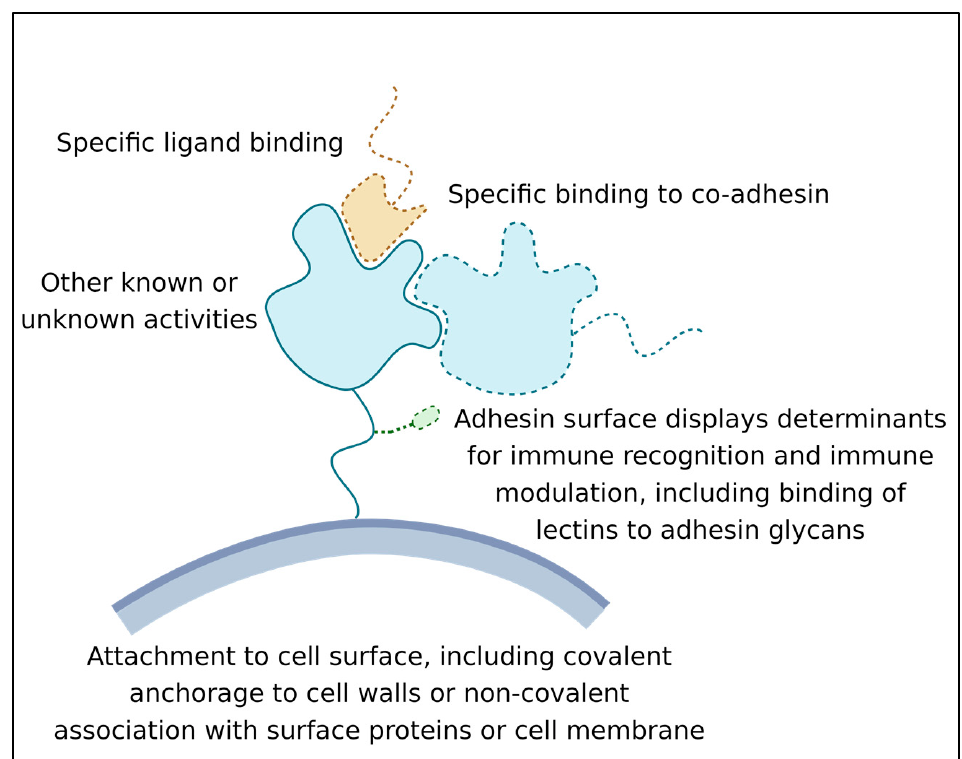
Figure 1. Some general features and activities of microbial adhesins. Adhesins (blue with a green glycosylation) are bound to cell wall (grey). The ligand is shown in tan.